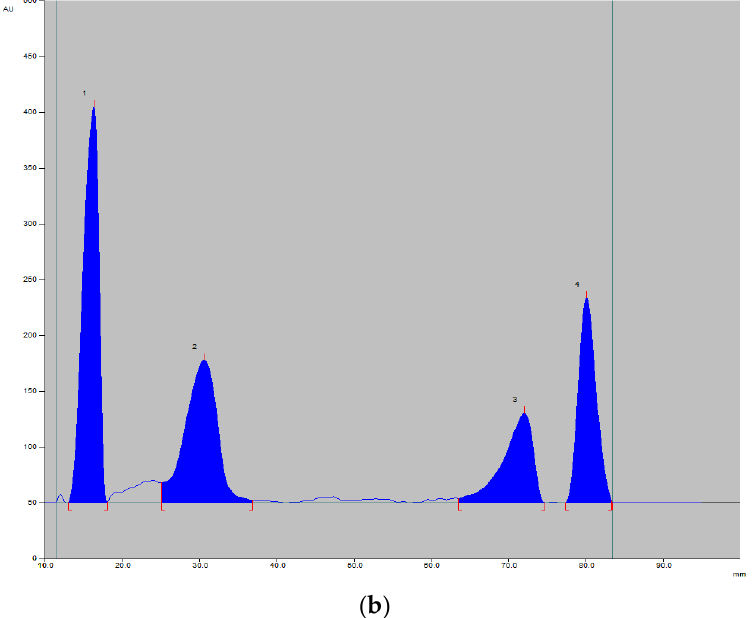
Figure 3. An example of a chromatogram under a UV lamp (254 nm; image) ( a ) and registered densitogram ( b ) showing the separation of vitamins 1—B1 (R F = 0.18), 2—B12 (R F = 0.33), 3—B6 (R F = 0.75), 4—B2 (R F = 0.81).